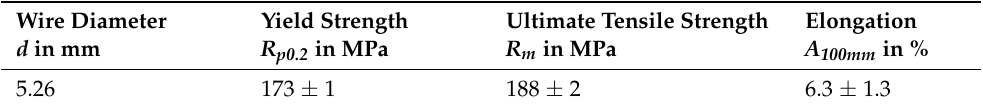
Table 2. Geometrical and mechanical properties of the 6056 aluminum alloy wire in the as-received condition. The deviation is given in absolute